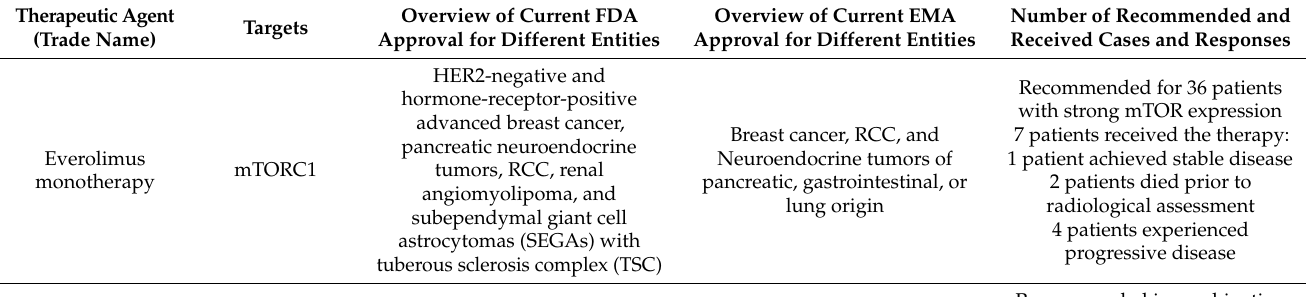
Table 3. Rationale for targeted therapy